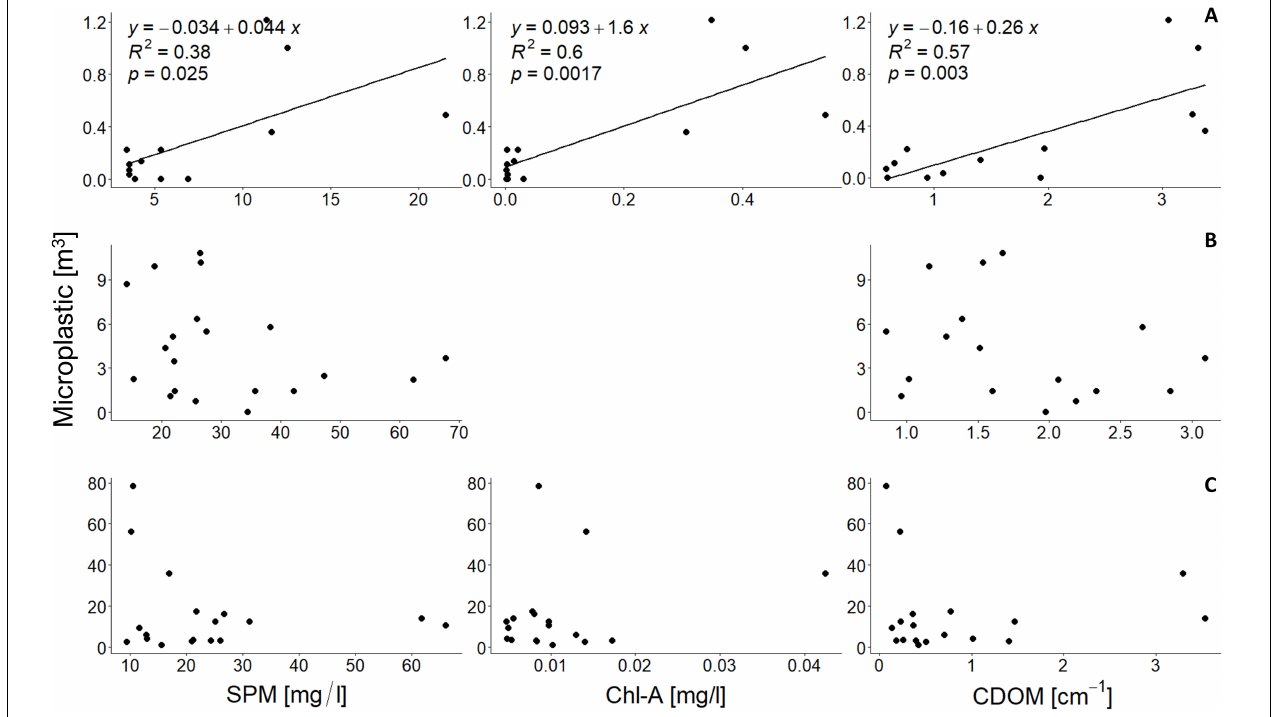
FIGURE 2 | Relationship between measured water constituents and microplastic (0.3–5 mm) at the Trave river (A) , the Elbe estuary (B) , and the Po delta (C) . Linear regression analysis revealed a significant positive relationship among the abundance of all three water constituents and microplastic abundance for the Trave river (A) . Chl-A, chlorophyll-a, SPM, suspended particulate matter, CDOM, colored dissolved organic